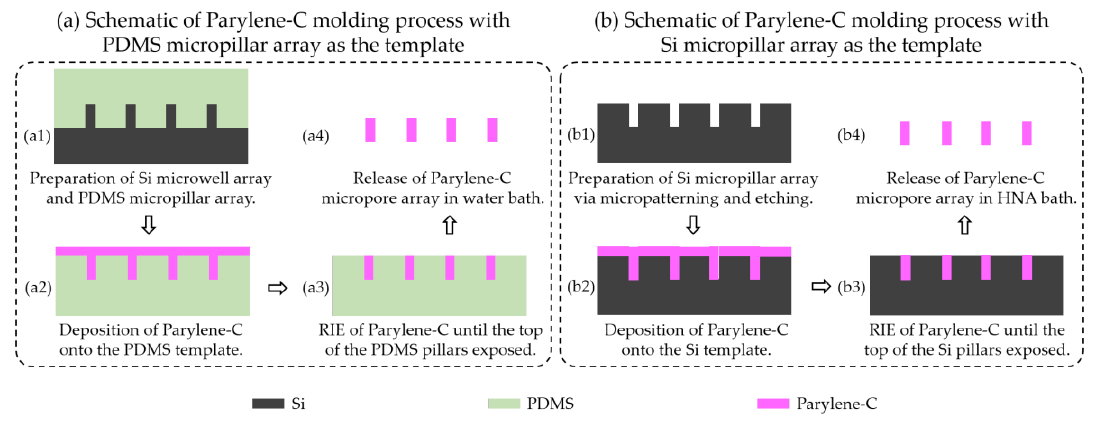
Figure 2. Schematic of the Parylene-C molding process with a polydimethylsiloxane (PDMS) ( a ) and Si ( b ) micropillar array as templates for micropore array preparation.